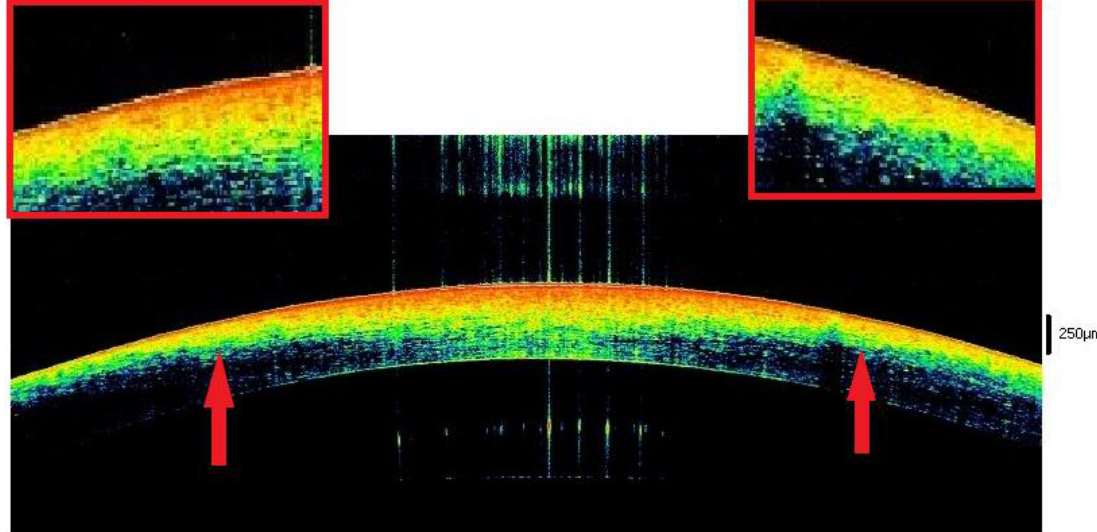
Figure 4. This image shows the progress of the dehydration phenomenon which also accentuates the physiological structural differences between the anterior and posterior stroma in opened eyes. The image shows the presence of an anterior hyper-reflective stroma which was separated from a posterior hyporeflective area by an irregular line with a saw-tooth morphology (indicated by red